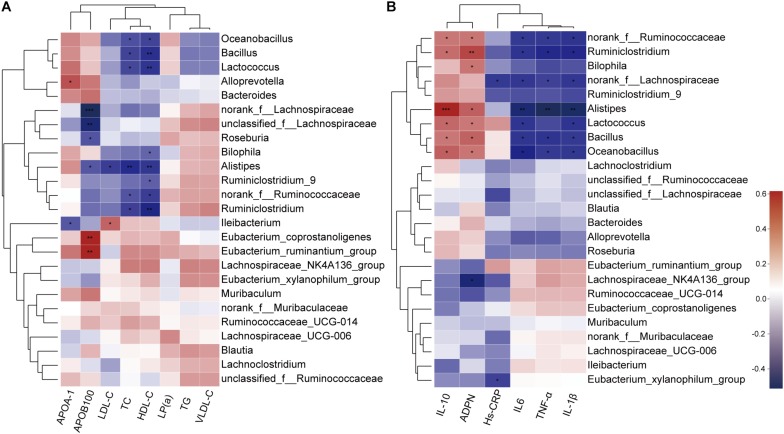
Spearman rank correlations between gut microbiota abundance and serum levels of lipids (A) and inflammatory cytokines (B). Red indicate being positive correlation and blue being negative. * 0.01 < p ≤ 0.05, ** 0.001 < p ≤ 0.01, *** p ≤ 0.001.